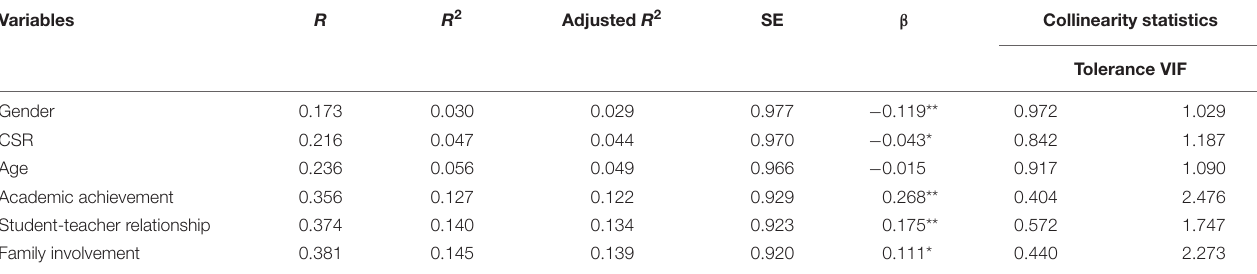
TABLE 5 | Regression analysis to predict Social Preference Index based on personal, socio-family, and school adaptation